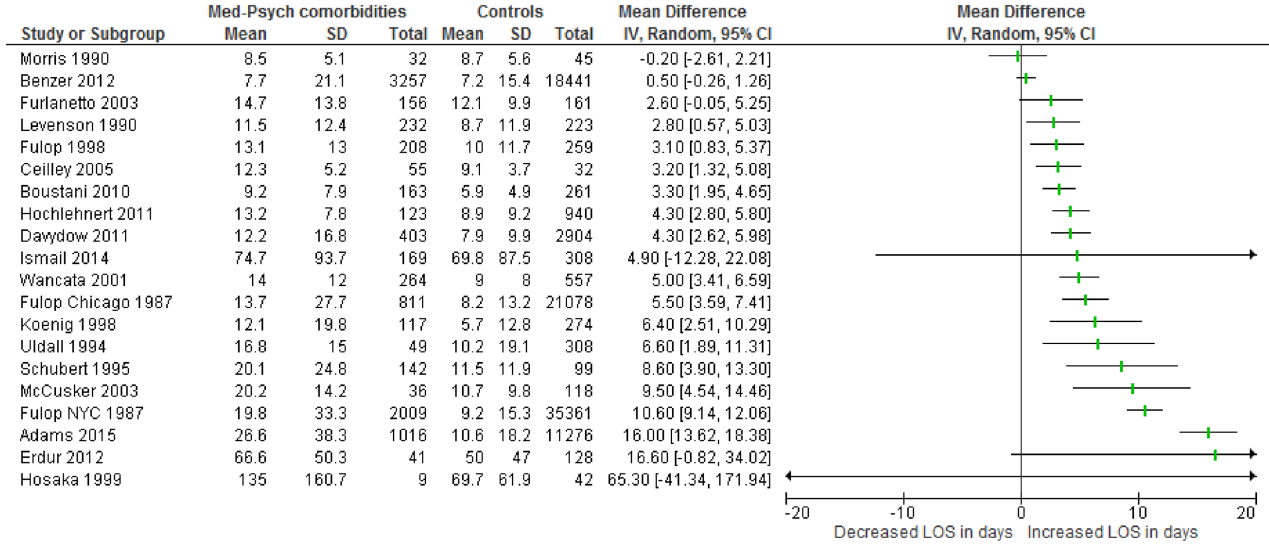
Fig 2. Relation of medical-psychiatric comorbidity and length of stay (LOS) (because the study of Fulop et al. [1987] included two separate samples in two hospitals, both outcomes are included in the analyses).